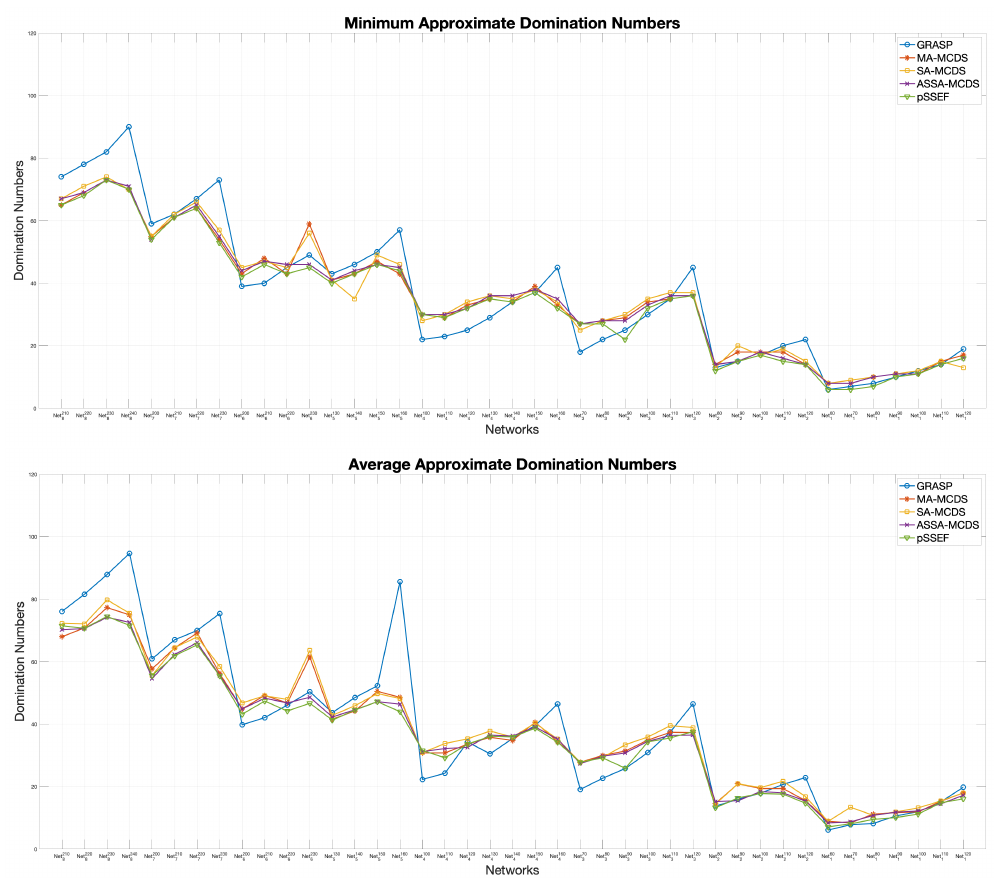
Figure 13. Compared results for big-size networks.